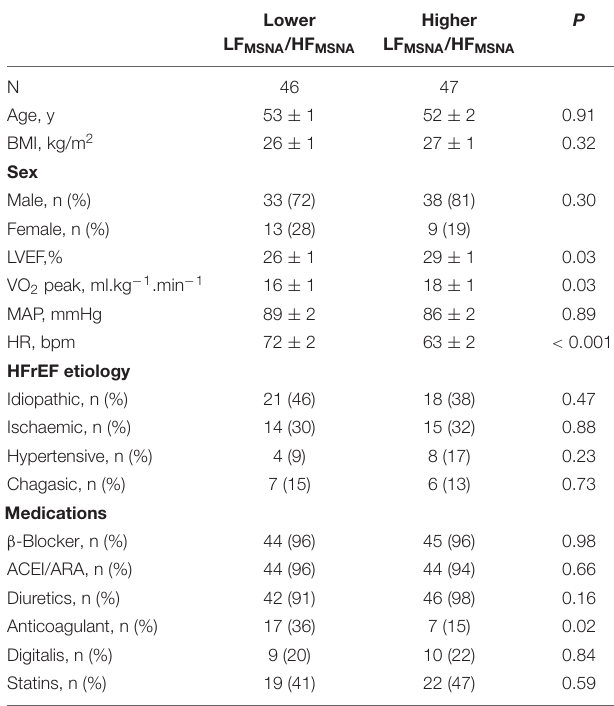
TABLE 1 | Baseline characteristics of HfrEF patients with lower and higher oscillatory pattern of